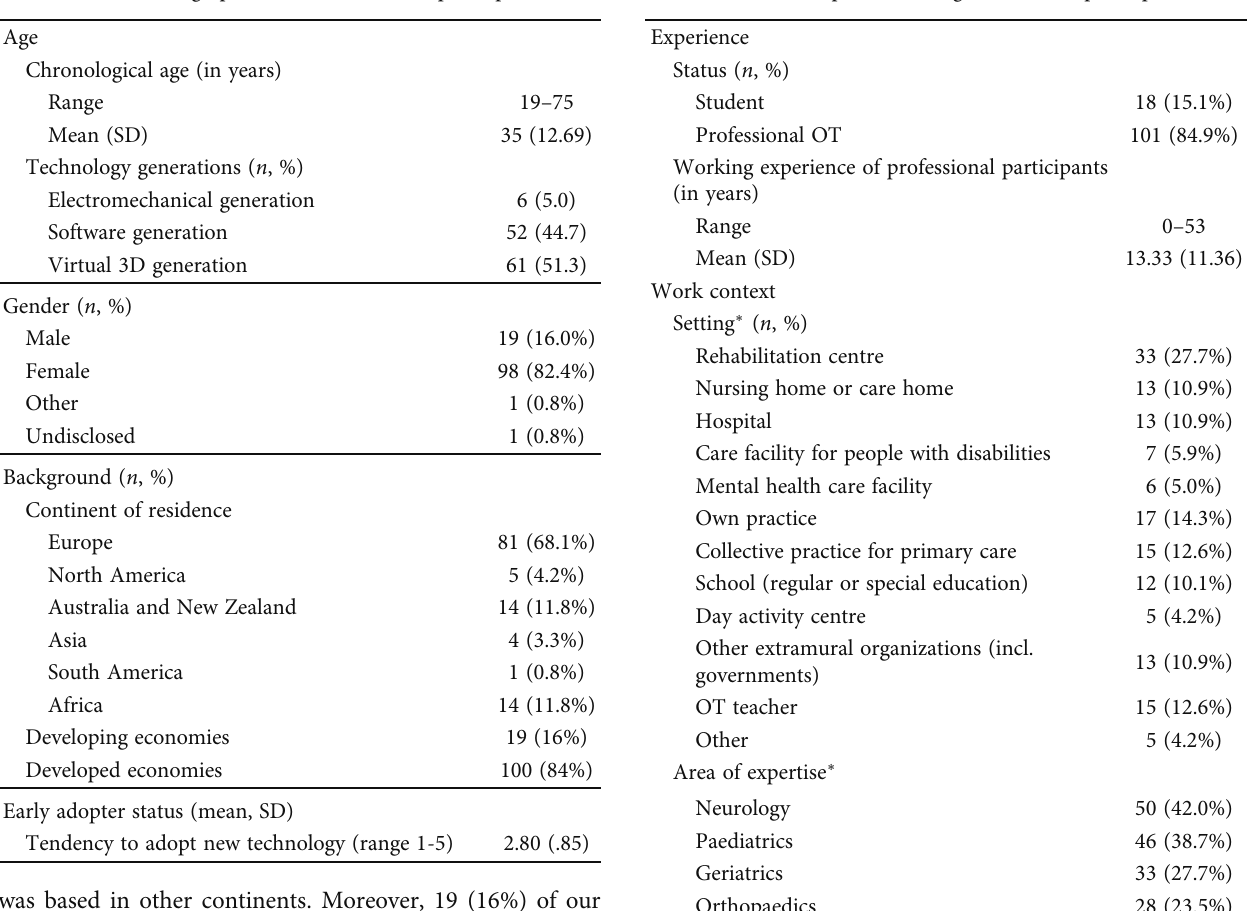
Table 1: Demographic information about participants. Table 2: Occupational background of the